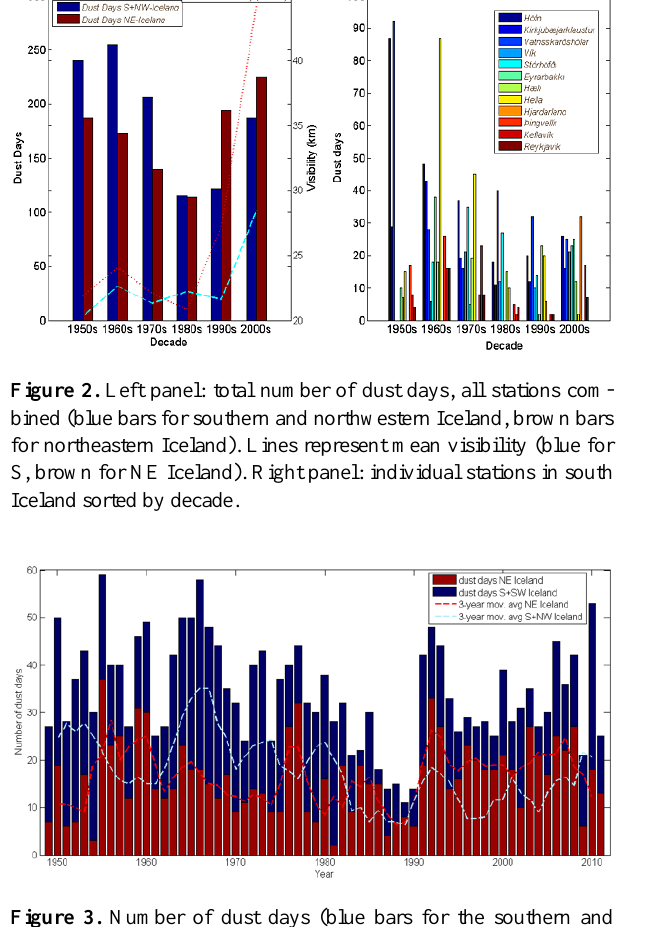
Figure 3. Number of dust days (blue bars for the southern and northwestern part of Iceland, brown bars for northeast Iceland) and 3year moving averages of dust day frequency (lines: red for NE, light blue for S Iceland).